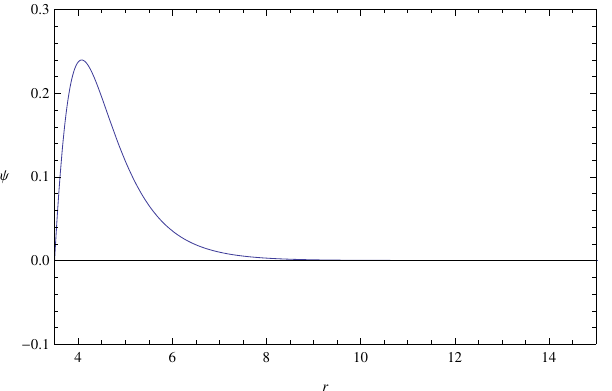
Figure 2 . (Color online) We show behaviors of the scalar (cid:12)eld function ( r ) with respect to the coordinate r for mr s = 3 : 5, mM = 1 : 5 and m 2 (cid:17) = 133 : 002493.